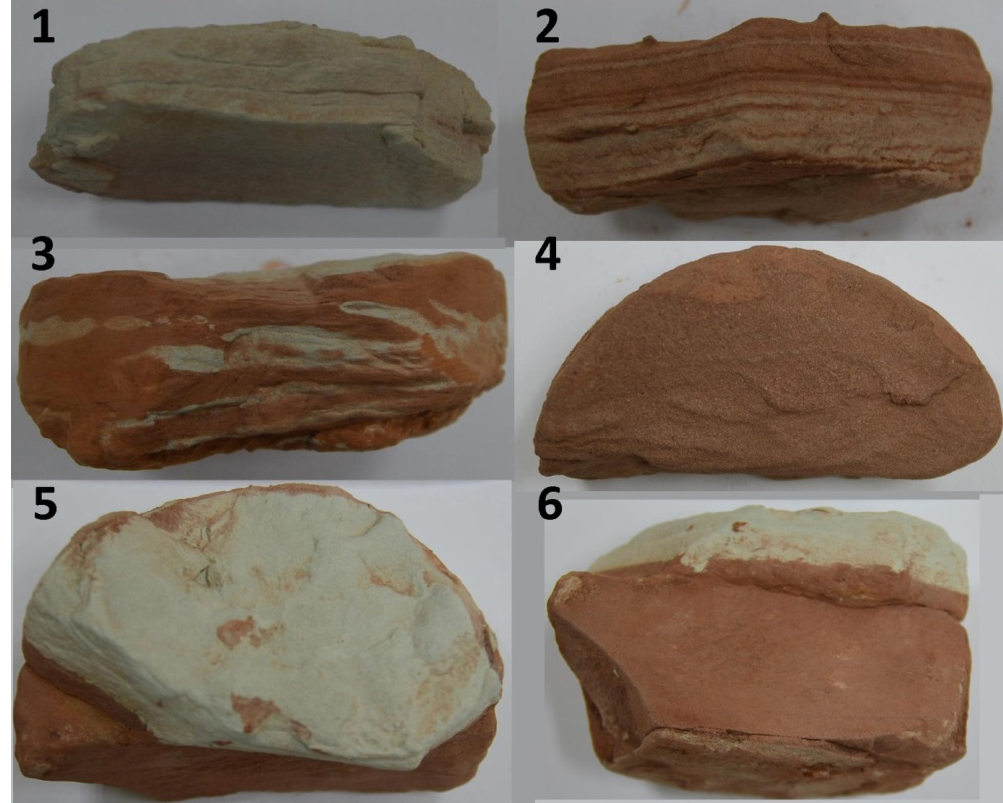
Figure 1. Photos of samples of studied rocks. 1—Green siltstones, 66.7–66.8 m. 2—Red sandstones, 75.2–75.3 m. 3—Variegated siltstones, 83.9–84 m. 4—Red siltstones, 94–94.1 m. 5–6—Green siltstones, 99.5–99.6 m (photo S. Druzhinin).